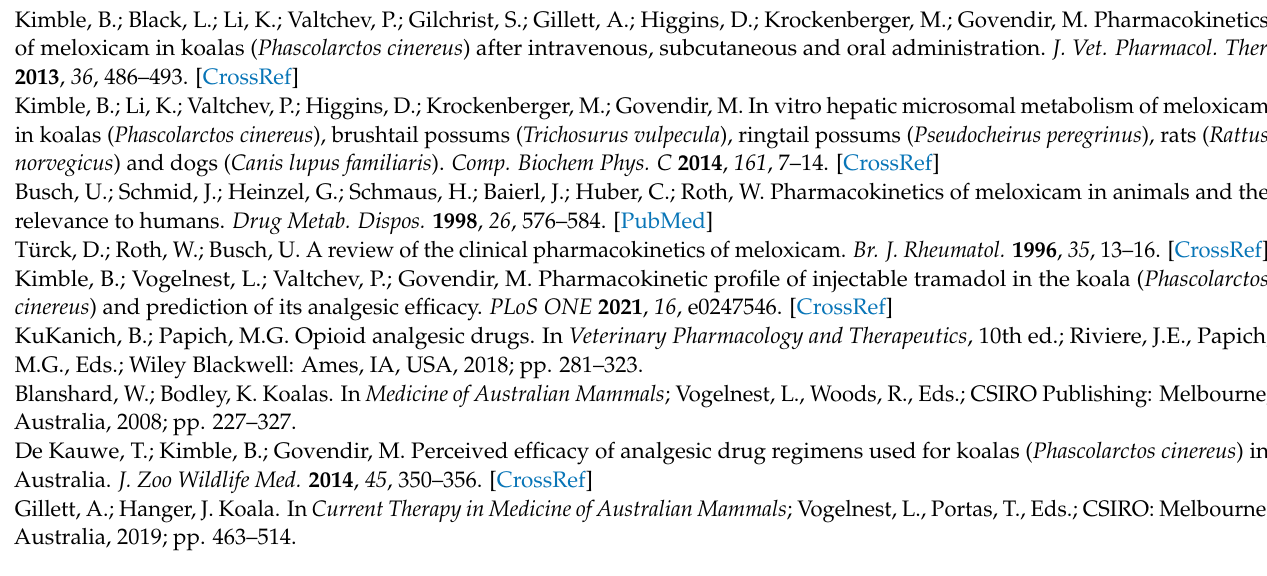
Table S3: Plasma fentanyl concentrations over time in each koala when administered as a single intravenous